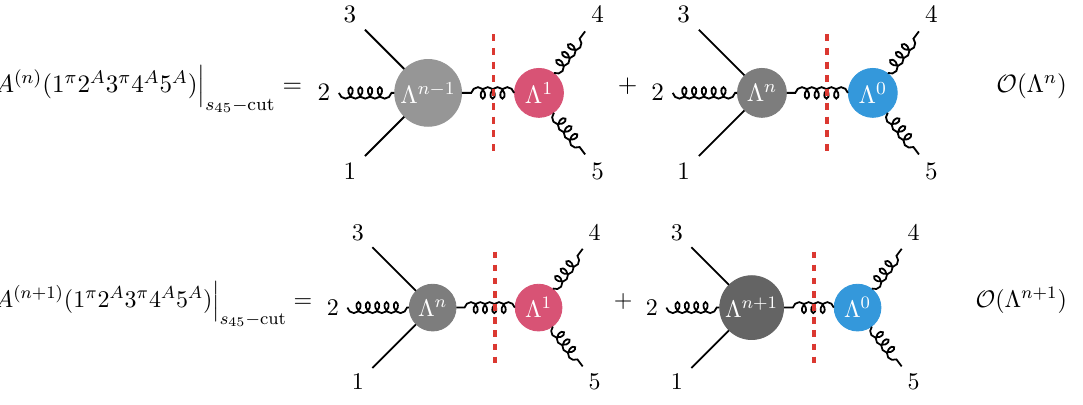
Figure 3 . Inductive ladder of higher-derivative contacts generated by consideration of color-dual consistency and cuts of the form A ( ππAA ) × ( A YM